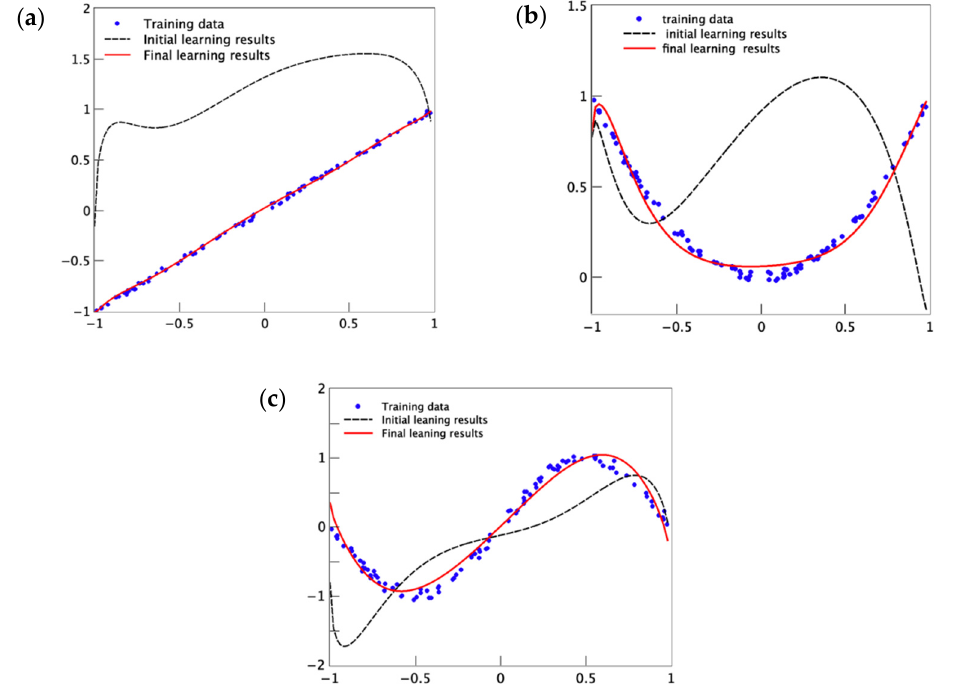
Figure 4. ( a ) Regression of target function f 1 ( x ) = x + 0.015 N ( 0, 1 ) . ( b ) Regression results for target function f 2 ( x ) = x 2 + 0.015 N ( 0, 1 ) . ( c ) Regression results for target function f 3 ( x ) = sin x + 0.015 N ( 0, 1 ) .